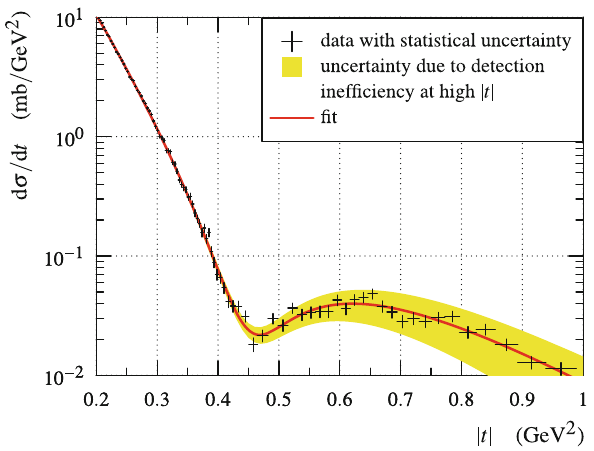
Fig. 13 Differential cross-section at higher | t | values as determined in the “2RP” analysis (black points) with a fit (red line) used for the evaluation of the CNI effects. The fit also allows for a first dip-bump characterisation at 13TeV: the dip is located at | t | ≈ 0 . 47GeV 2 , the bump at | t | ≈ 0 . 62GeV 2 and the bump/dip cross-section ratio is about 1 . 8 (a more recent and precise quantification can be found in Ref. [41]). For comparison: at 7TeV the dip was found at 0 . 53GeV 2 [12] and the bump/dip ratio 1 . 7 ± 0 . 1 (local polynomial fit of the data in Table 5 in Ref.